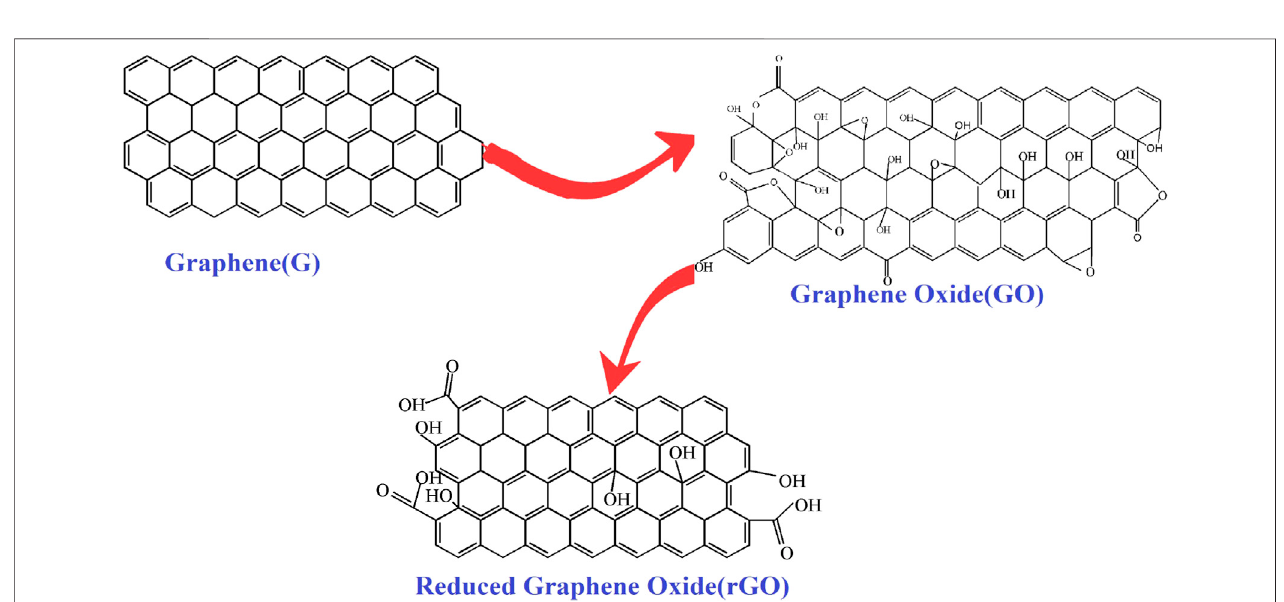
FIGURE 2 | The structural differences of graphene and modi fi ed